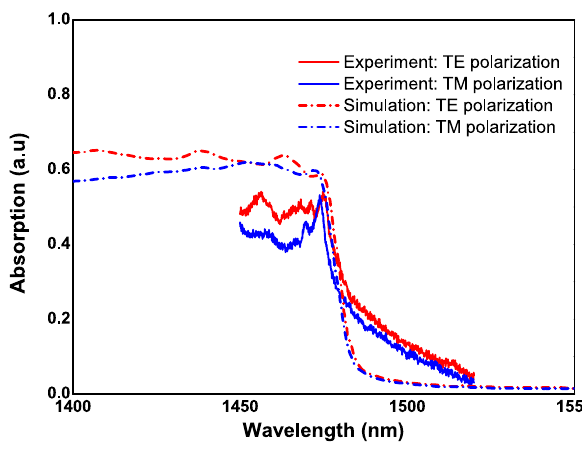
Figure 7: Absorption spectra of the 0.72% biaxially tensile-strained